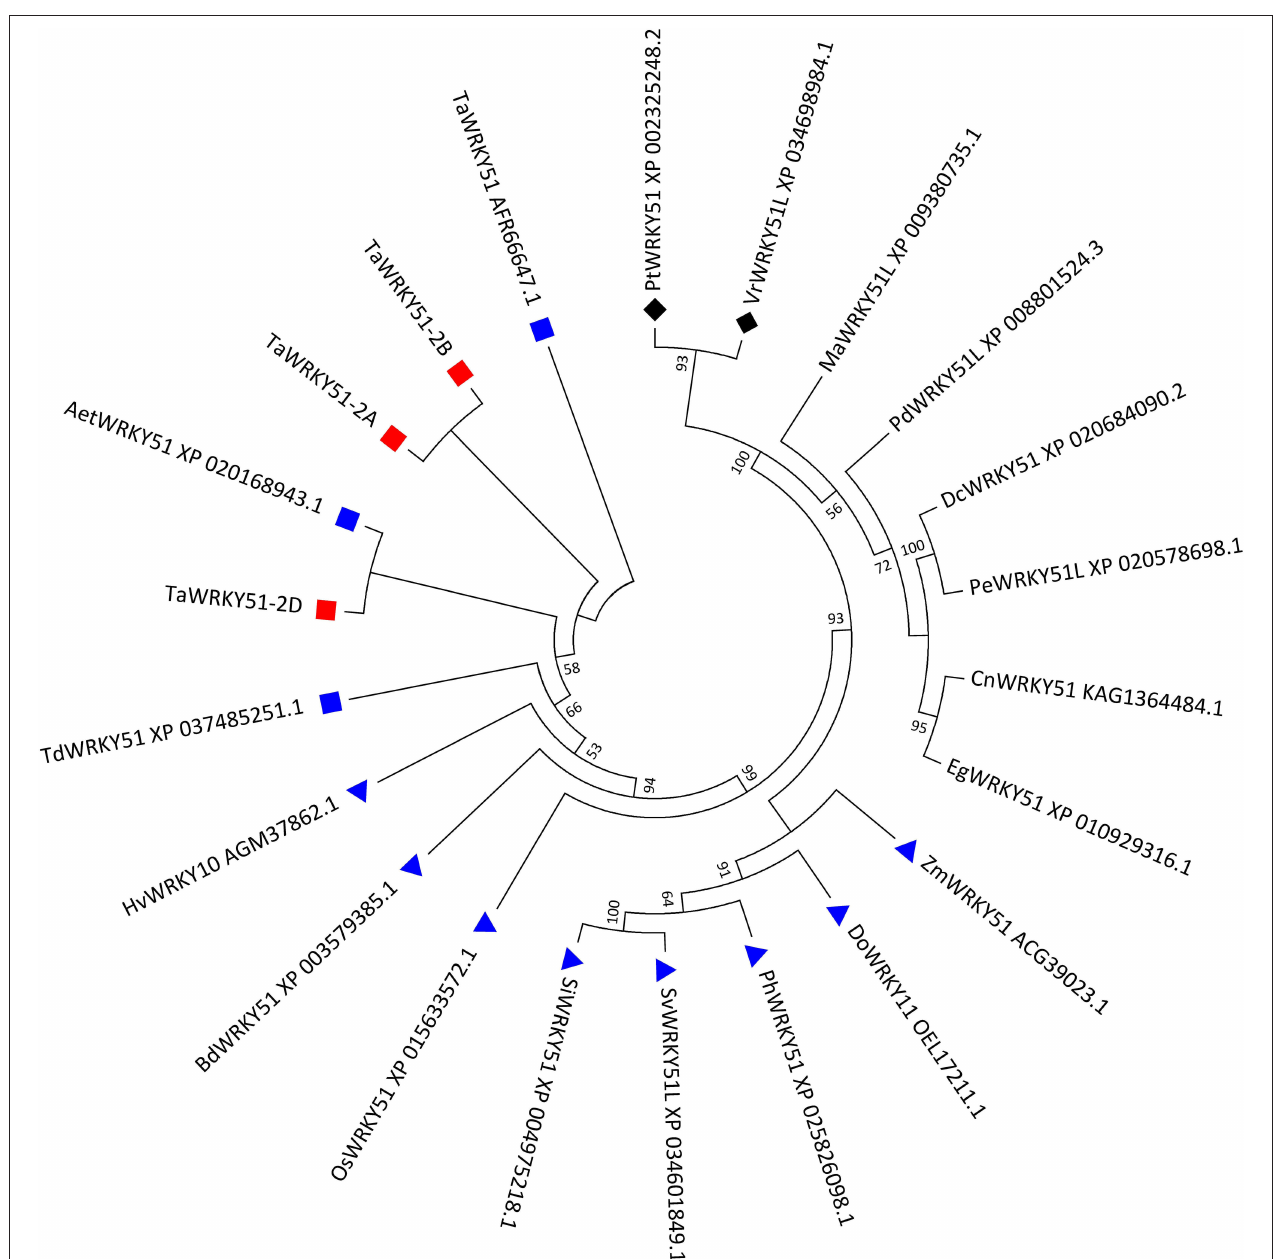
FIGURE 1 | Phylogenetic tree of TaWRKY51s and the orthologs in the selected plant species. The evolutionary history was inferred by using the maximum likelihood method based on Poisson’s correction model. The bootstrap consensus tree inferred from 1,000 replicates was taken to represent the evolutionary history of the taxa analyzed. The evolutionary analyses were conducted in MEGA7. Blue squares indicate wheat or wheat relatives. Blue triangles indicate the graminaceous crops or species. Black diamonds indicate the dicot species. Aet, Aegilops tauschii ; Bd, Brachypodium distachyon ; Cn, Cocos nucifera ; Dc, Dendrobium catenatum ; Do, Dichanthelium oligosanthes ; Eg, Elaeis guineensis ; Hv, Hordeum vulgare ; Ma, Musa acuminata ; Pd, Phoenix dactylifera ; Os, Oryza sativa ; Pe, Phalaenopsis equestris ; Ph, Panicum hallii ; Pm, Panicum miliaceum ; Pt, Populus trichocarpa ; Si, Setaria italica ; Sv, Setaria viridis ; Ta, T. aestivum ; Td, T. dicoccoides ; Vr, Vitis riparia ; and Zm, Zea maize .